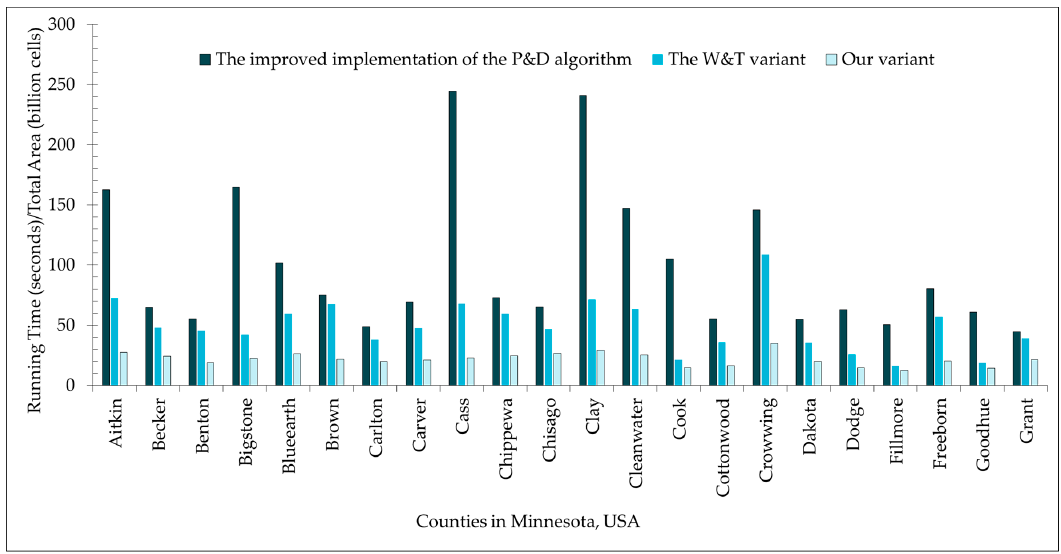
Figure 4. Running time of the improved implementation of the P&D algorithm, the W&T variant and